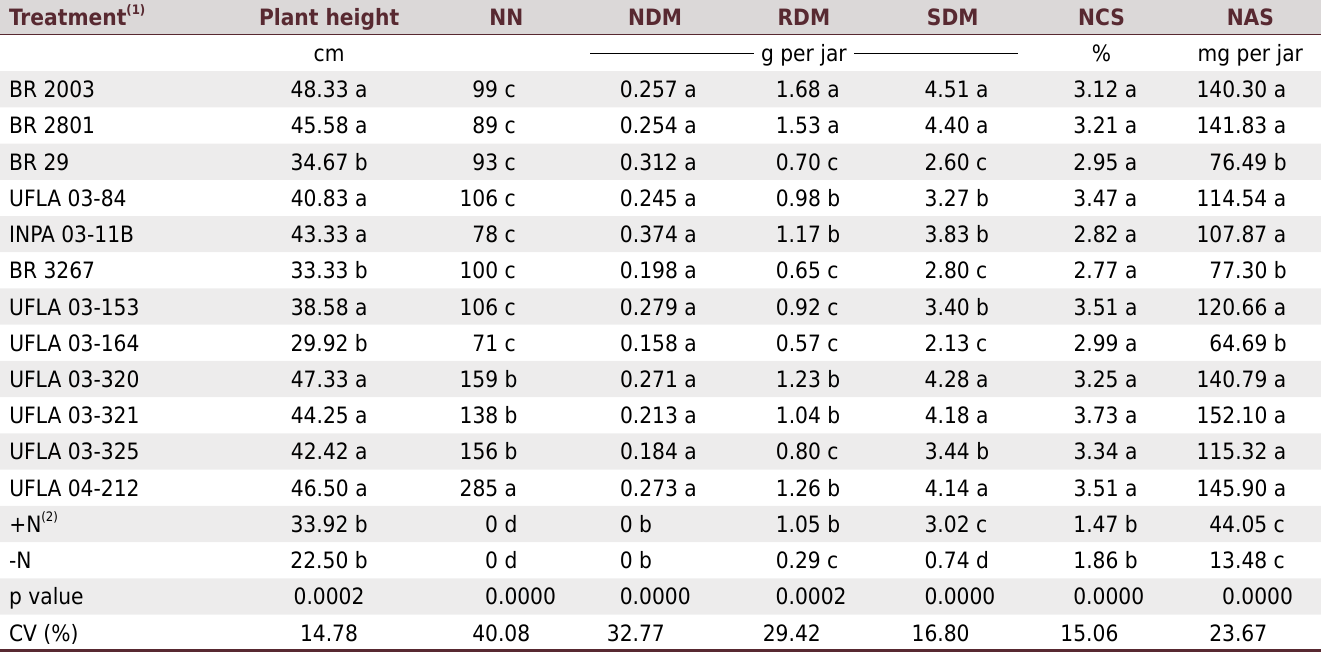
Table 3. Plant height, number of nodules (NN), nodule dry matter (NDM), root dry matter (RDM), shoot dry matter (SDM), nitrogen content in the shoot (NCS), and nitrogen accumulation in the shoot (NAS) of pigeon pea cv. IAC Fava-Larga cultivated in